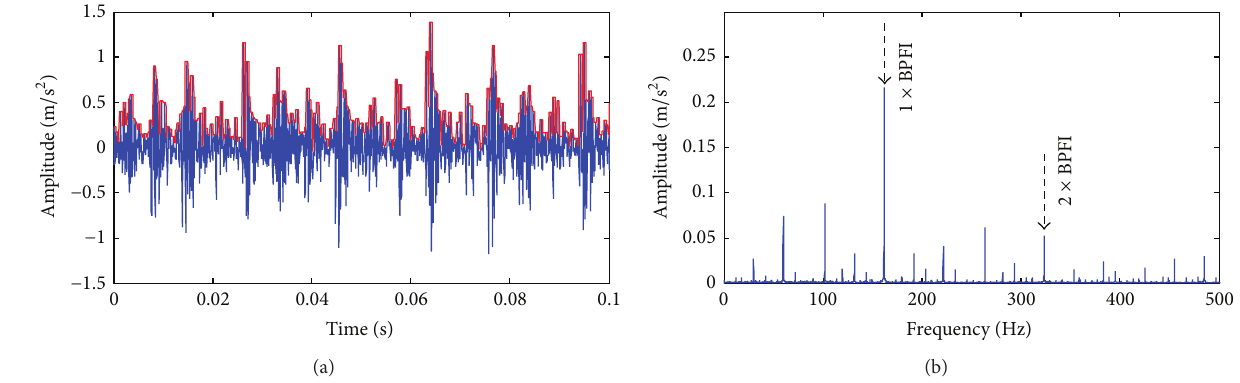
Figure 8: (a) Results of morphological operation dilation; (b) frequency spectrum of